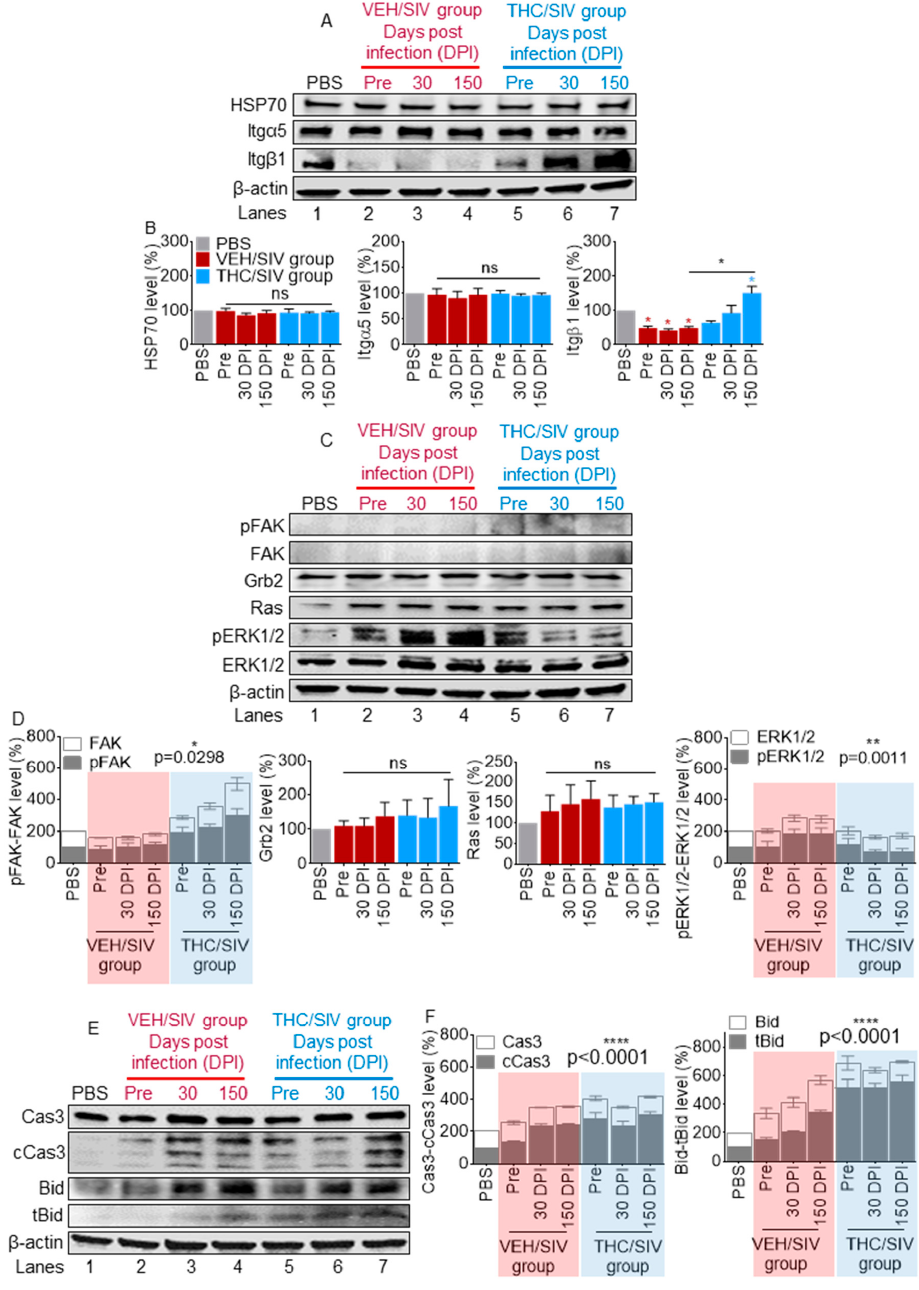
Figure 7. THC / SIV BEVs dampen SIV-induced changes in intracellular signaling: (A,B) representative Western blot images of HSP70, Itg α 5 and Itg β 1 ( A ) and densitometry quantification of three independent repeats ( B ). (C,D) Representative Western blot of kinases, their activators, and adaptor ( C ) and densitometry quantification of three independent repeats ( D ). (E,F) Representative levels of proteins linked to cell death ( E ) and densitometry quantification of three independent repeats ( F ). The relative band density was determined by normalizing to β -actin and PBS control. Ordinary one-way ANOVA (Brown–Forsythe and Bartlett tests, with Sidak’s multiple comparisons test) was used to determine the statistical significance within the group. Two-way ANOVA (groups x proteins) was used to determine the statistical significance for pFAK / FAK, pERK1 / 2 / ERK1 / 2, cCas3 / Cas3 and tBid / Bid. * p < 0.05, ** p < 0.01, **** p < 0.001, and ns =